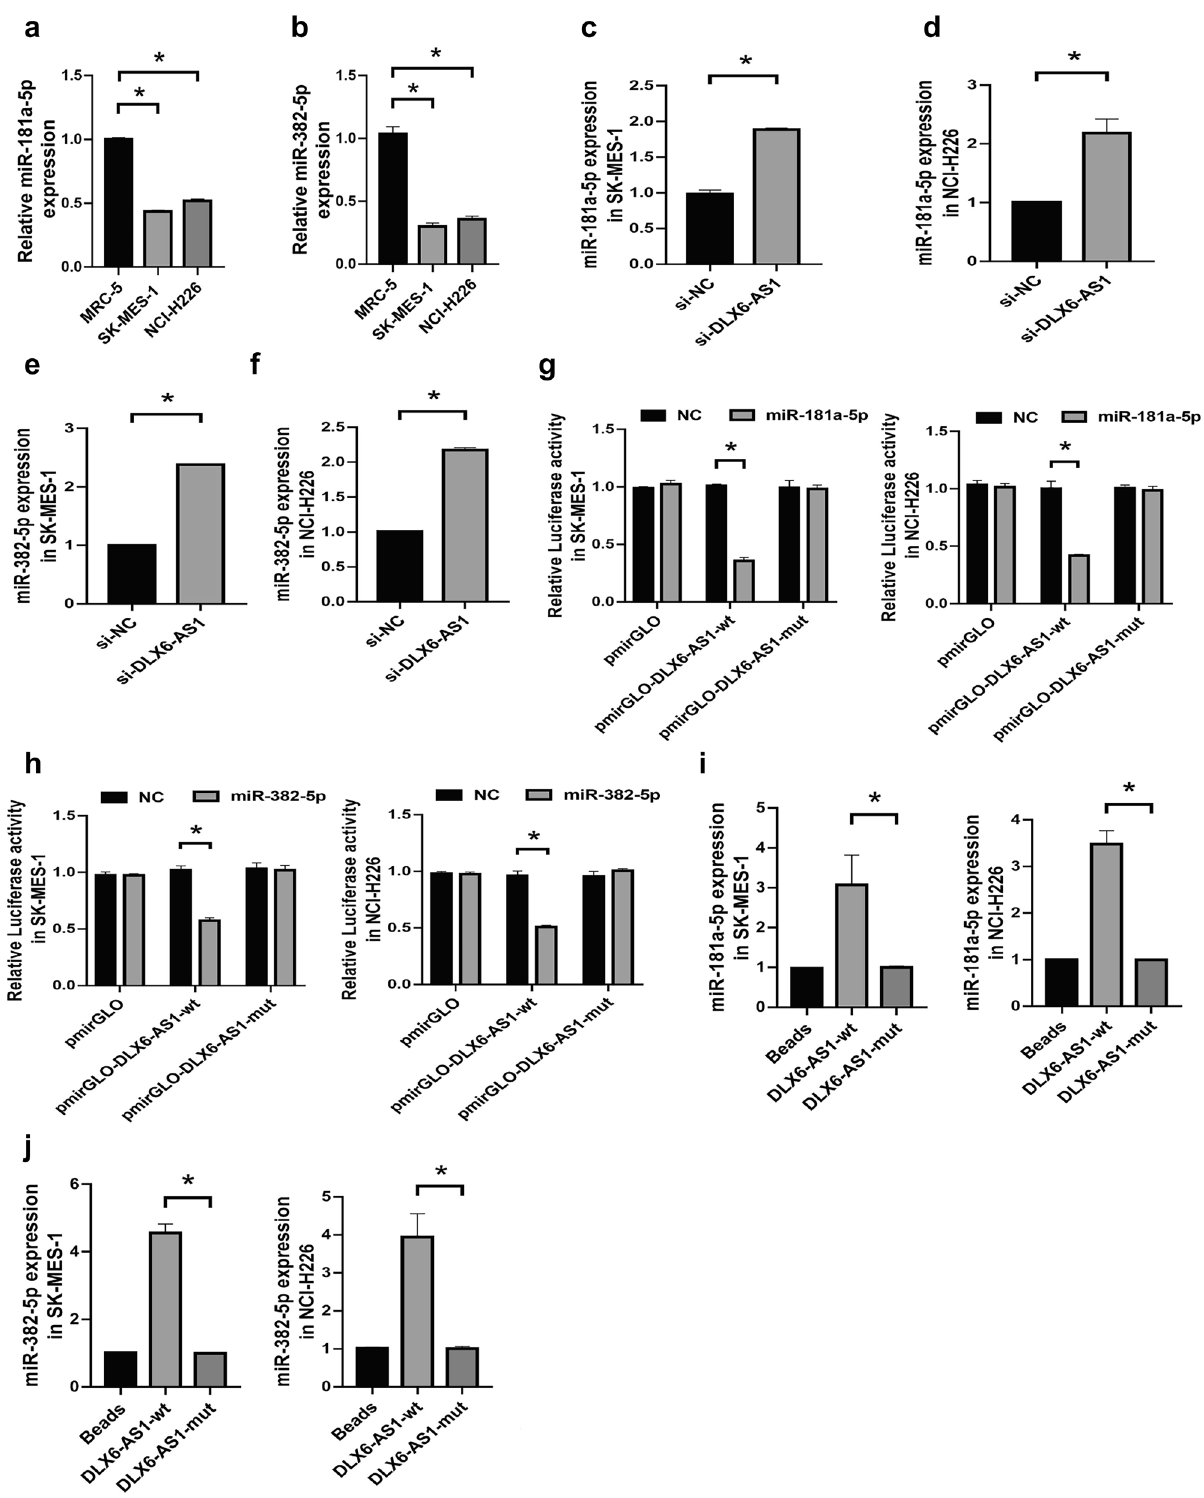
Figure 3. DLX6-AS1 negatively regulated the expression of miR-181a-5p and miR-382-5p. ( a,b ) qRT-PCR analysis for the relative expression of miR-181a-5p ( a ) or miR-382-5p ( b ) in SK-MES-1, NCI-H226, and MRC-5 cell lines. ( c,d ) The relative expression of miR-181a-5p in SK-MES-1 ( c ) and NCI-H226 ( d ) cell lines transfected with si-DLX6-AS1 or si-NC was estimated by qRT-PCR analysis. ( e,f ) The relative expression of miR-382-5p in SK-MES-1 ( e ) and NCI-H226 ( f ) cell lines transfected with si-DLX6-AS1 or si-NC was estimated by qRT-PCR analysis. ( g ) The binding relationship between DLX6-AS1 and miR-181a-5p in SK-MES-1 or NCI- H226 cells was verified by performing Dual luciferase reporter gene assay. ( h ) The binding relationship between DLX6-AS1 and miR- 382-5p in SK-MES-1 or NCI-H226 cells was verified by performing Dual luciferase reporter gene assay. ( i ) The interaction between DLX6-AS1 and miR-181a-5p in SK-MES-1 or NCI-H226 cells was estimated via RNA pull down assay. ( j ) The interaction between DLX6-AS1 and miR-382-5p in SK-MES-1 or NCI-H226 cells was estimated via RNA pull down assay. * P <